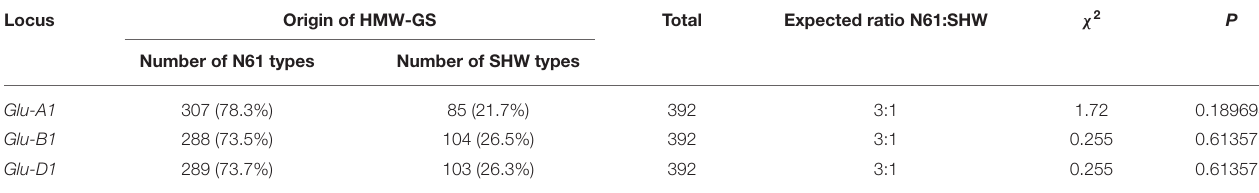
TABLE 1 | The segregation of HMW-GSs in each locus of MSD lines.